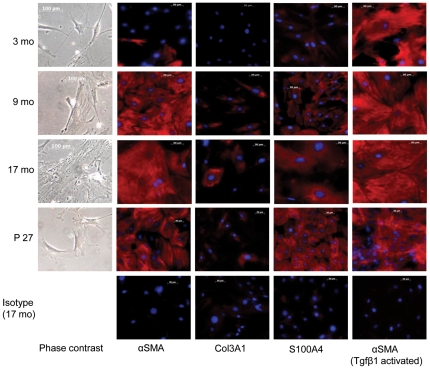
Morphology and phenotype of aging lung fibroblasts.Comparison of explant-grown lung fibroblasts derived from 3, 9 and 17 month old mice, as well as passage 29 (XP27) cells derived from 3 mo mice, grown in 0% serum (200× phase contrast micrographs), as well as lung fibroblasts positive for αSMA, Col3A1 and S100A4 (red), compared to all nucleated cells (blue) (200× micrographs). Representative isotype controls (using fibroblasts from 17 month mice) are included for reference.